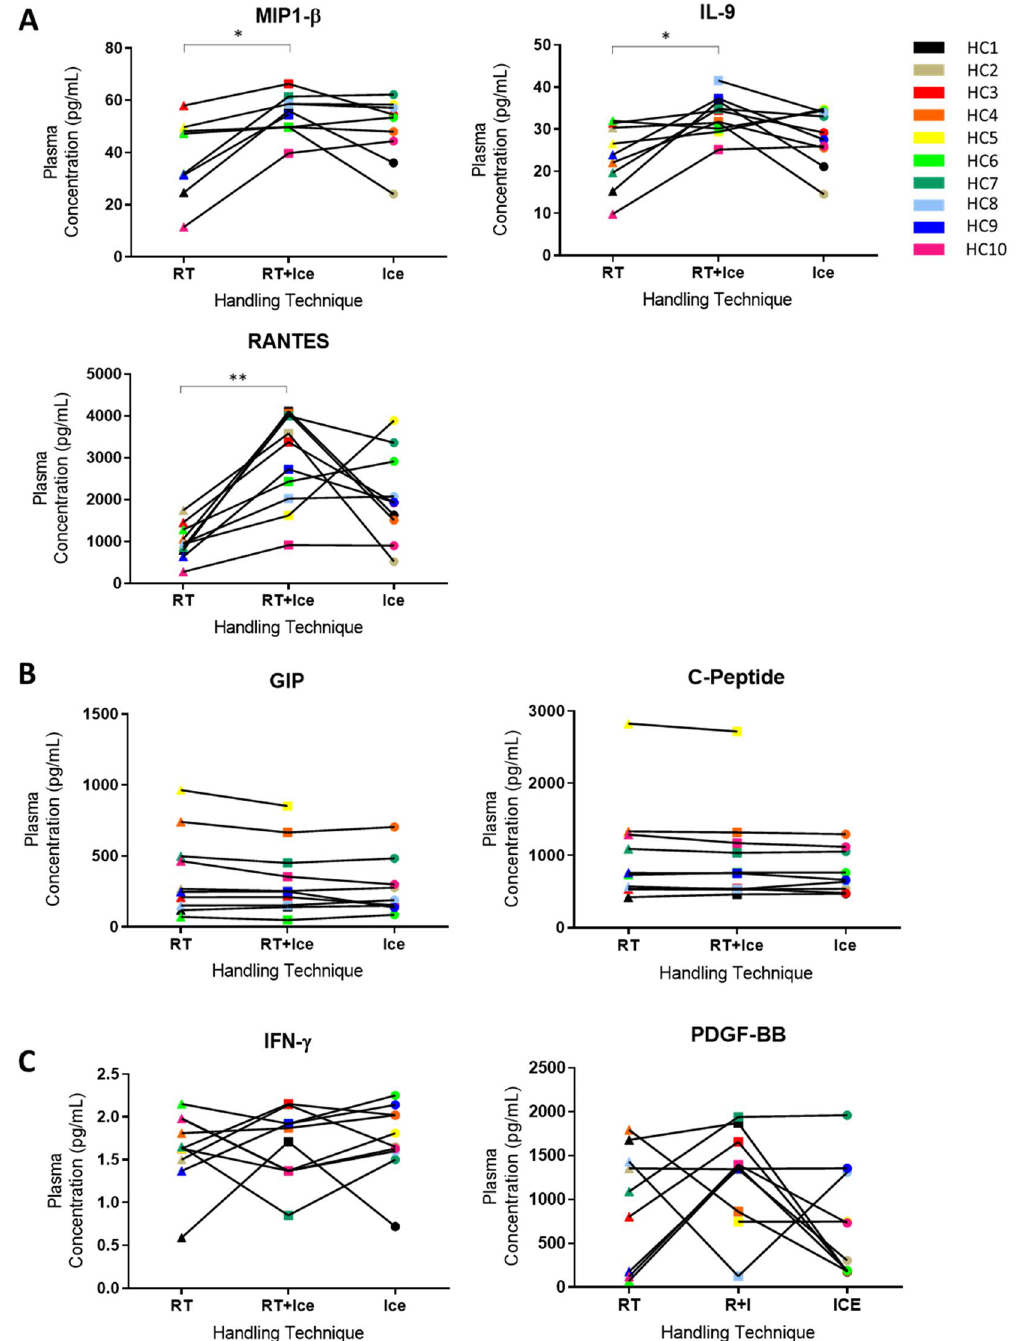
Figure 2. The effects of alternative pre-processing protocols on plasma analyte levels. The plasma levels of selected analytes in healthy control samples following three pre-processing protocols are shown. The reference protocol, 1 h at room temperature (RT) and two alternative protocols, 1 h at room temperature followed by a further 3 h on ice (RT + Ice) or 1 h on ice (Ice) were compared. ( A ) Significant differences were identified in the levels of MIP1-B, IL-9 and RANTES levels. ( B ) Some analytes demonstrated minimal changes. ( C ) While no statistically significant differences are observed for some analytes, specific individual samples undergo considerable changes in response to handling variables. Paired t-tests were performed to examine for significant differences between mean analyte levels in samples from reference and alternative protocols. * represents p ≤ 0.05, ** represents p <